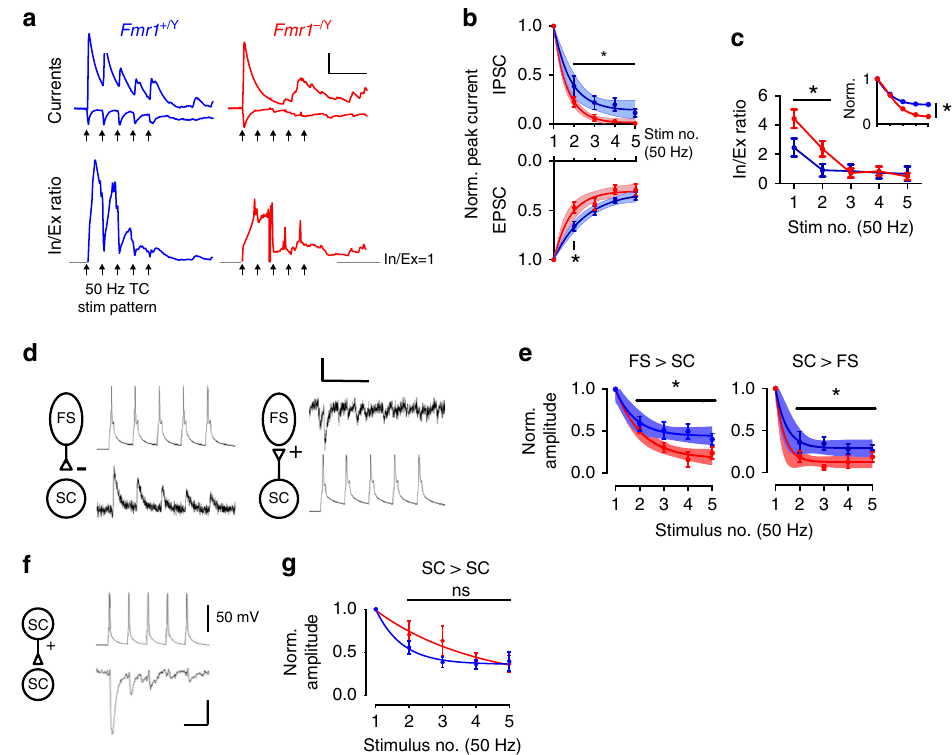
Fig. 4 Synapse-speci fi c changes to short-term plasticity in P10 – 11 Fmr1-KO mouse. a Top: Example voltage-clamped synaptic currents during repetitive TC stimulation at 50 Hz. Note strong amplitude attenuation of TC-evoked and FFI currents in Fmr1 − /Y . Bottom: Instantaneous G/A ratios for the above traces calculated by dividing FF-IPSC amplitudes by EPSCs for each sampled point in time. Note: (1) the graded attenuation of G/A ratio in the Fmr1 + /Y and slow onset of G/A balance during stimulus train despite large amplitude FF-IPSC, (2) Temporally disorganised ratio in the Fmr1 − /Y . Arrows show stimulation times. Scale: 50 ms/100pA, G/A = 1. b Short-term depression of EPSCs and FF-IPSCs during 5 × 50 Hz stimulation: Evoked current amplitudes normalized to steady-state amplitude. Error bars: mean ± SEM normalized peak amplitude after for each stimulus for Fmr1 + /Y (blue, N = 19 (EPSCs) and N = 11 (FF- IPSCs) neurons) and Fmr1 − /Y (red, N = 15 (EPSCs) and N = 12 (FF-IPSCs) neurons). Asterisks: signi fi cantly different stimulus responses between genotypes ( t -test, p < 0.05). Shaded regions are best ± 95% CI fi ts to bi-exponential decay functions. For both EPSCs and FF-IPSCs, the rate of depression for Fmr1 − /Y responses was faster and a single (i.e. common) fi t could not adequately explain the behaviour of both genotypes (Extra sum-of-squares F-test, EPSCs: p = 0.0007, F(2,163) = 7.65, IPSCs: p = 0.0002, F(2,111) = 9.45, N ’ s as above). c Data from ( b ) represented as stimulus-by-stimulus G/A ratios from FF-IPSCs by EPSCs. Inset shows data normalised to starting G/A ratios. Asterisks indicate stimuli with signi fi cant reductions in G/A ratio for Fmr1 − /Y data ( t -test, N ’ s as in ( b )). d Example short-term depression (50 Hz stimulus frequency) of unitary connections between FS-SC and SC-FS neurons (left, right) from paired recordings. Single trials shown. Scale: 50 mV, 10 pA/50 ms. e Short-term plasticity analysis in ( b ) but for unitary connections tested between connected pairs of FS and SC neurons (Asterisks: p < 0.05, t -test, fi ts: ( p < 0.05, Extra sum-of-squares F-test N : FS to SC Fmr1 + /Y = 9, Fmr1 − /Y = 8, SC to FS: Fmr1 + /Y = 9, Fmr1 − /Y = 6). N ’ s indicate neurons). f As for ( d ) but for example connected SC – SC paired recording. Scale: 50 mV, 5 pA/25ms. g Short-term depression of SC – SC connections was indistinguishable between genotypes ( p < 0.05, t -test, N = 17 Fmr1 + /Y , 11 Fmr1 − /Y